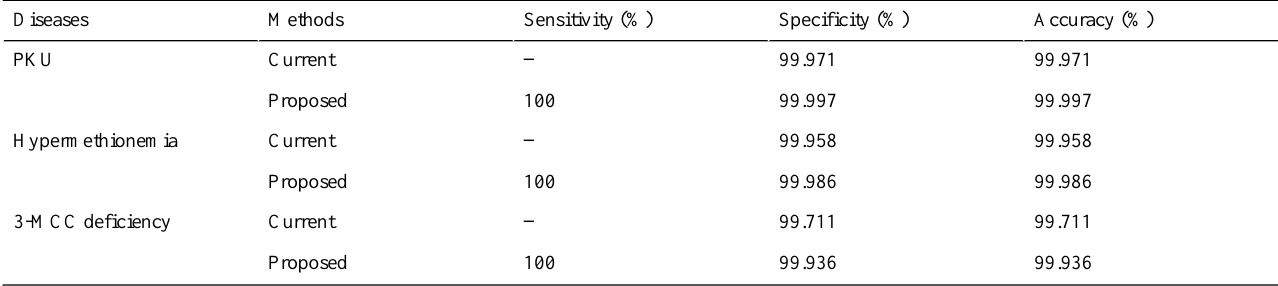
Table 3. Comparison of the current versus the proposed method. The sensitivity, specificity and accuracy are calculated from predicting the neonatal samples of 2011.